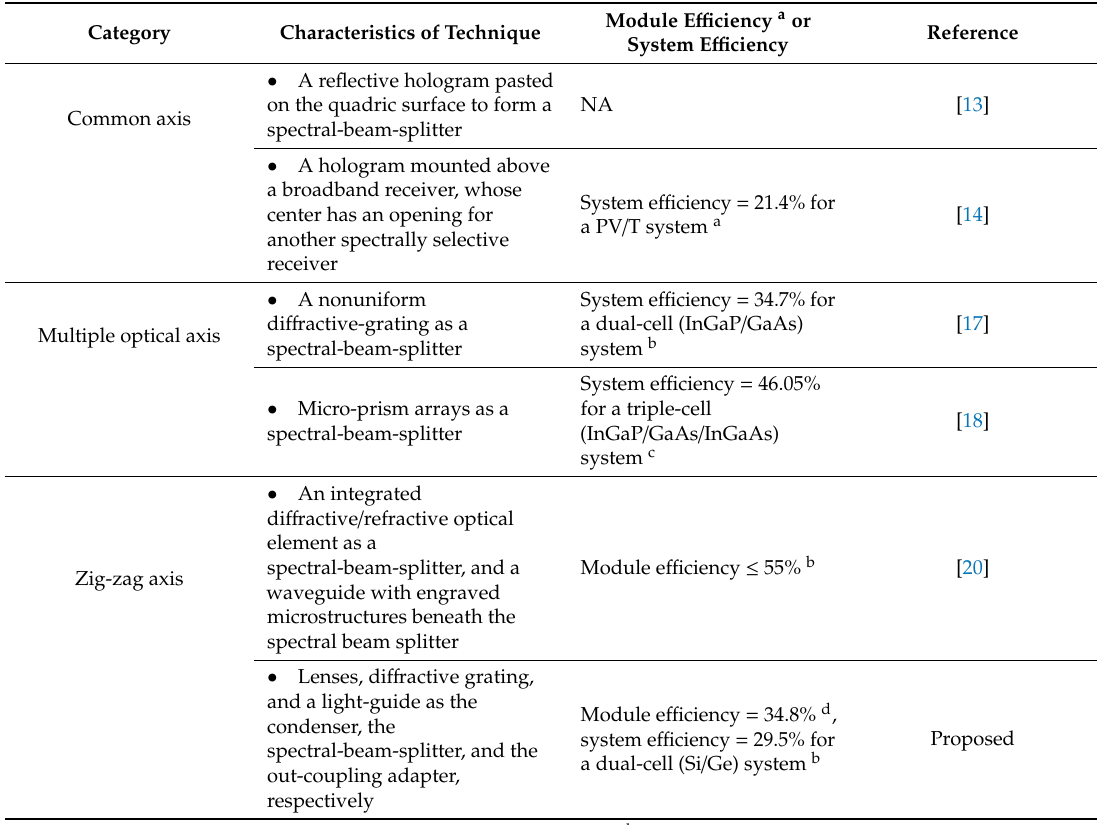
Table 3. Comparisons between the di ff erent di ff ractive-spectral-beam-splitters (SBS) techniques.